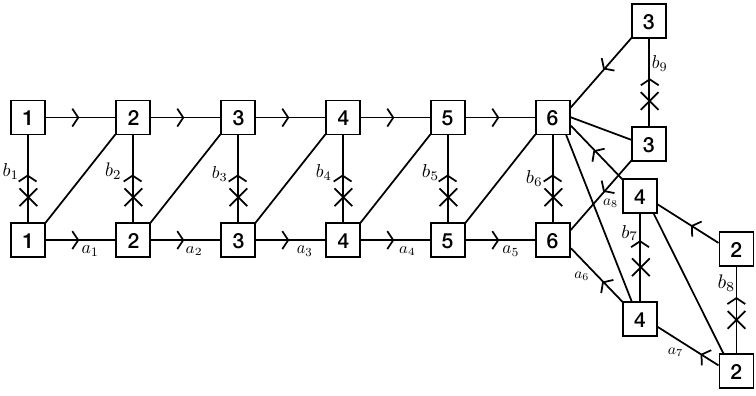
Figure 17 . Basic domain wall in the a(cid:14)ne E 8 quiver theory with D = f + 8 g (cid:12) . The integer numbers l i in the boxes denote the SU( l i N ) gauge symmetries at the